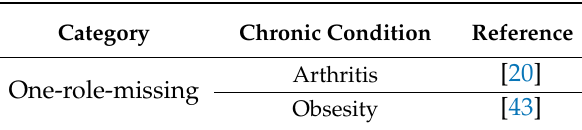
Table 9. One-role-missing chosen examples.